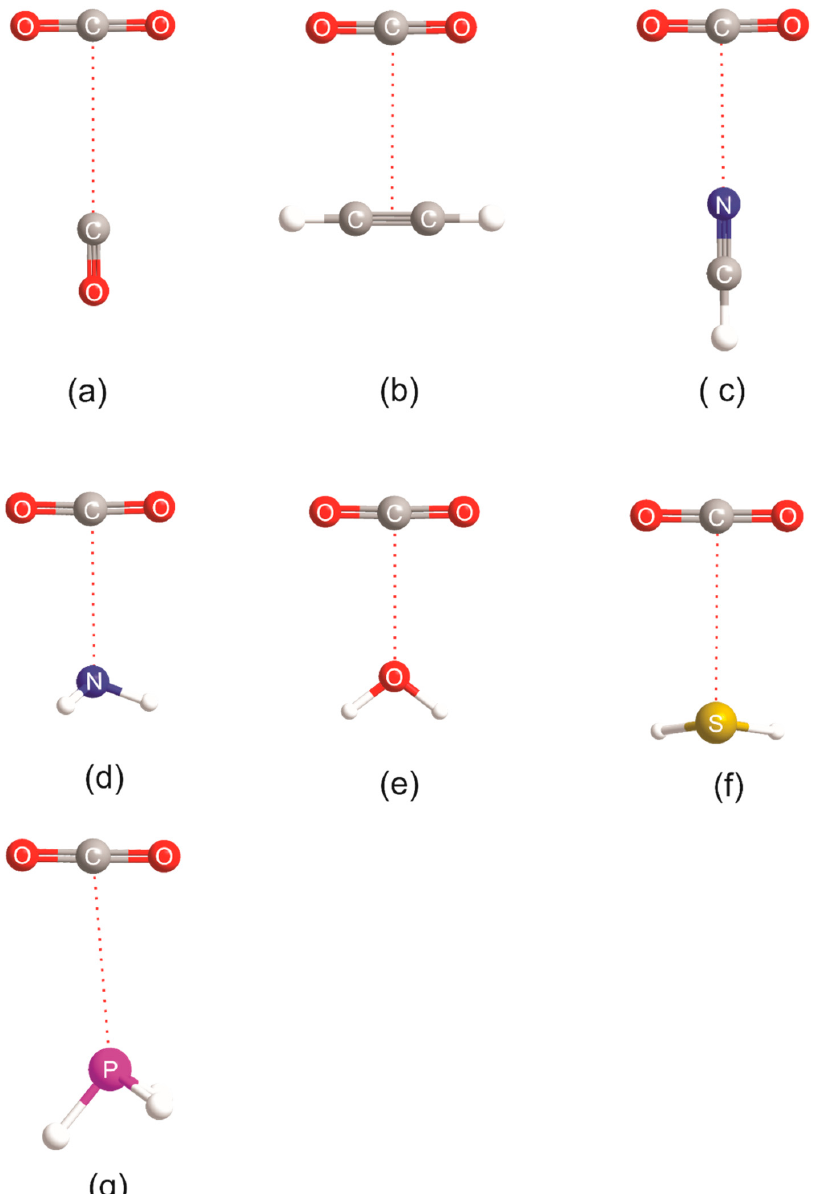
Figure 3. Molecular models drawn to scale of the geometries of B ⋯ CO 2 complexes calculated at the CCSD(T)/aug-cc-pVTZ level of theory, where B = CO, HCCH, HCN, NH 3 , H 2 O, H 2 S, and PH 3 ( a – g , respectively). Not shown is the linear, hydrogen-bonded isomer CO 2 ⋯ HCN, which is 1.5 kJ·mol − 1 higher in energy than the form in ©.